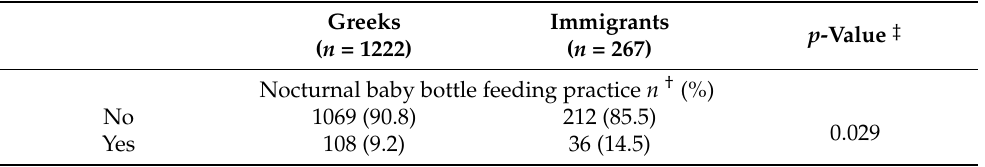
Table A1. Distribution of 5-year-old children of immigrant and of native Greek origin according to having a history of nocturnal baby bottle feeding